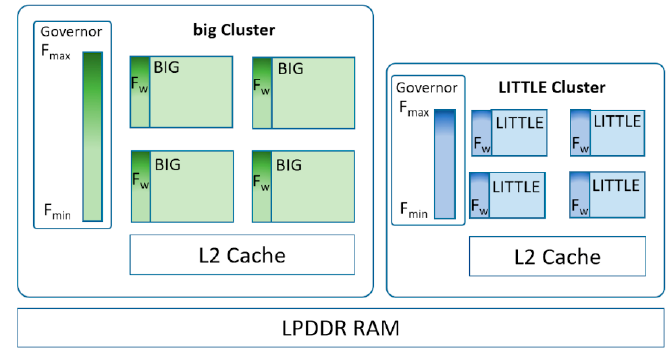
Figure 2. Typical big.LITTLE architecture, where governor regulates the frequency of each cluster. Table 1. Interactive parameters.